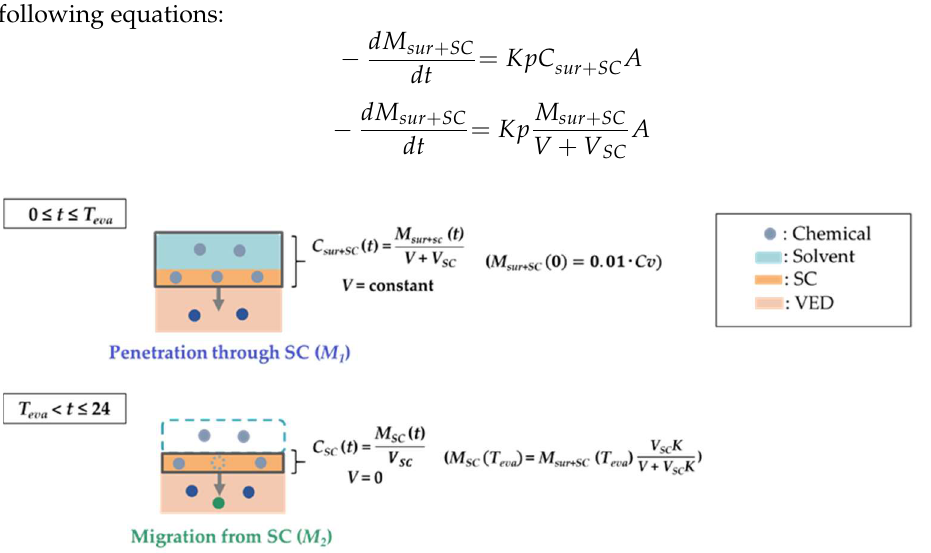
Figure 1. Flow diagram for time course of the chemical amount ( M ( t )) and concentration ( C ( t )) under finite dose conditions. M sur+SC ( t ) and C sur+SC ( t ) refer to the chemical amount and concentration at the skin surface and in the SC; M SC ( t ) and C SC ( t ) refer to the chemical amount and concentration in the SC; V , Vsc and K refer to solvent volume, SC volume and partition coefficient, respectively; t and T eva refer to time after starting the permeation experiment and time when the solvent was completely evaporated solvent,